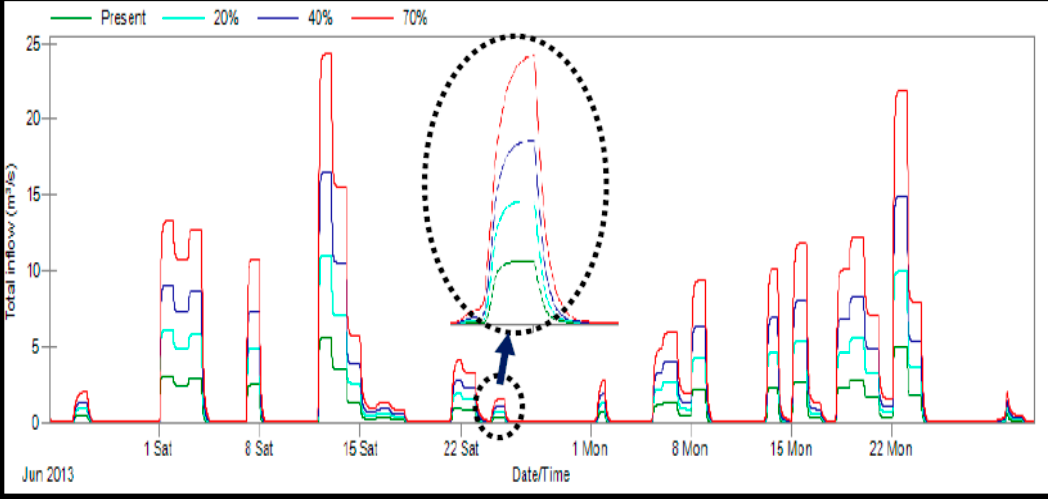
Figure 7. Urbanization effects on individual hydrographs.